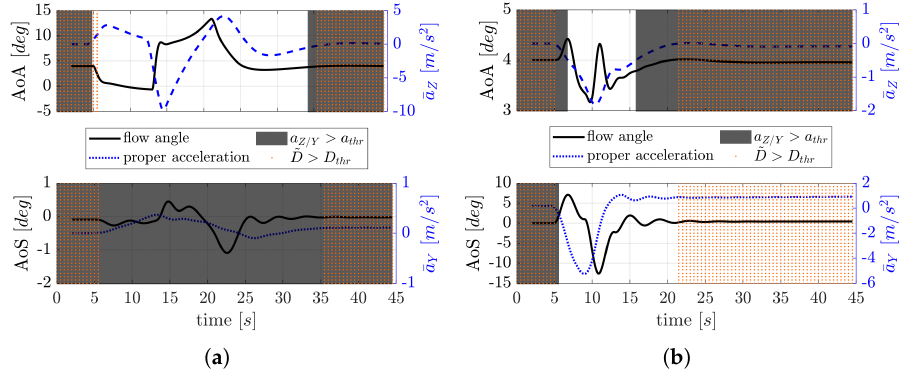
Figure 11. Verification manoeuvres. The shaded areas indicate the regions where the corresponding inertial acceleration modules are below the predefined threshold a thr and dotted areas indicate where the determinant is below a predefined threshold D thr . ( a ) Stall manoeuvre, ( b ) AoS sweep